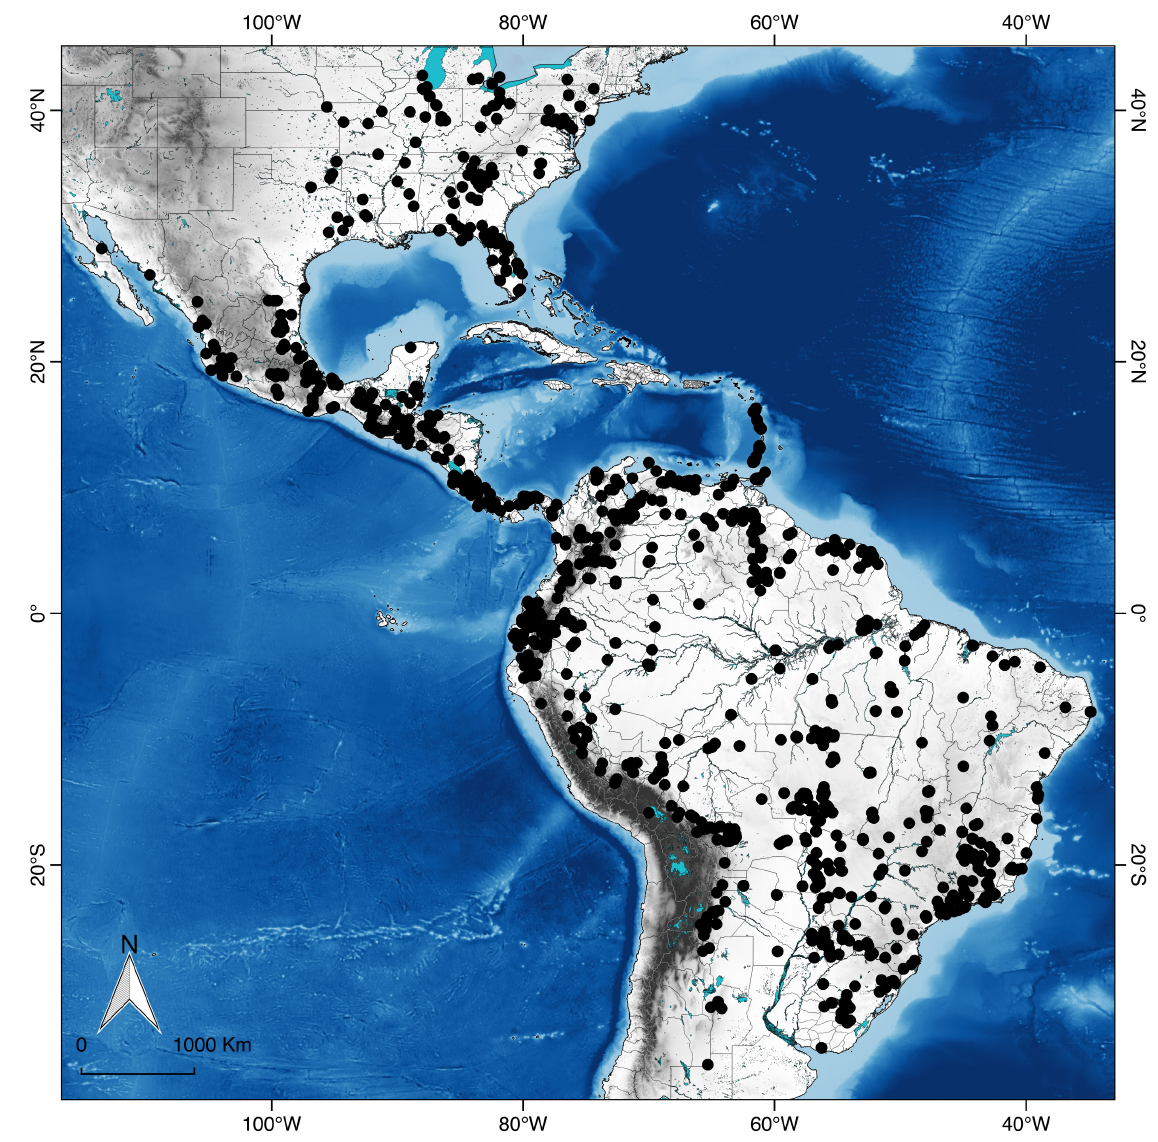
Fig. 4. Geographical range of the